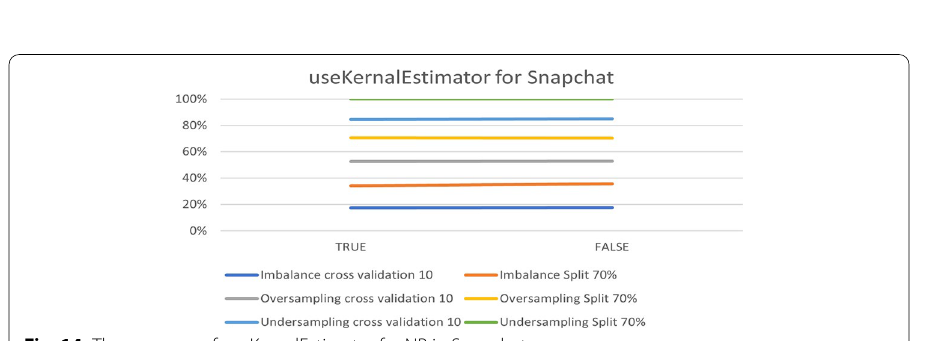
Fig. 14 The accuracy of useKernalEstimator for NB in